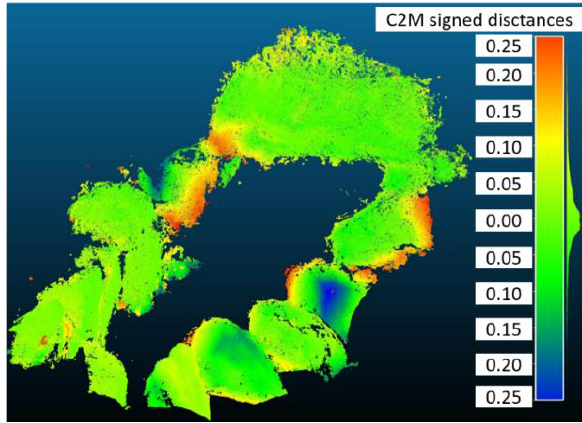
Figure 6: Comparison between modern mesh and point cloud from historical images in m.